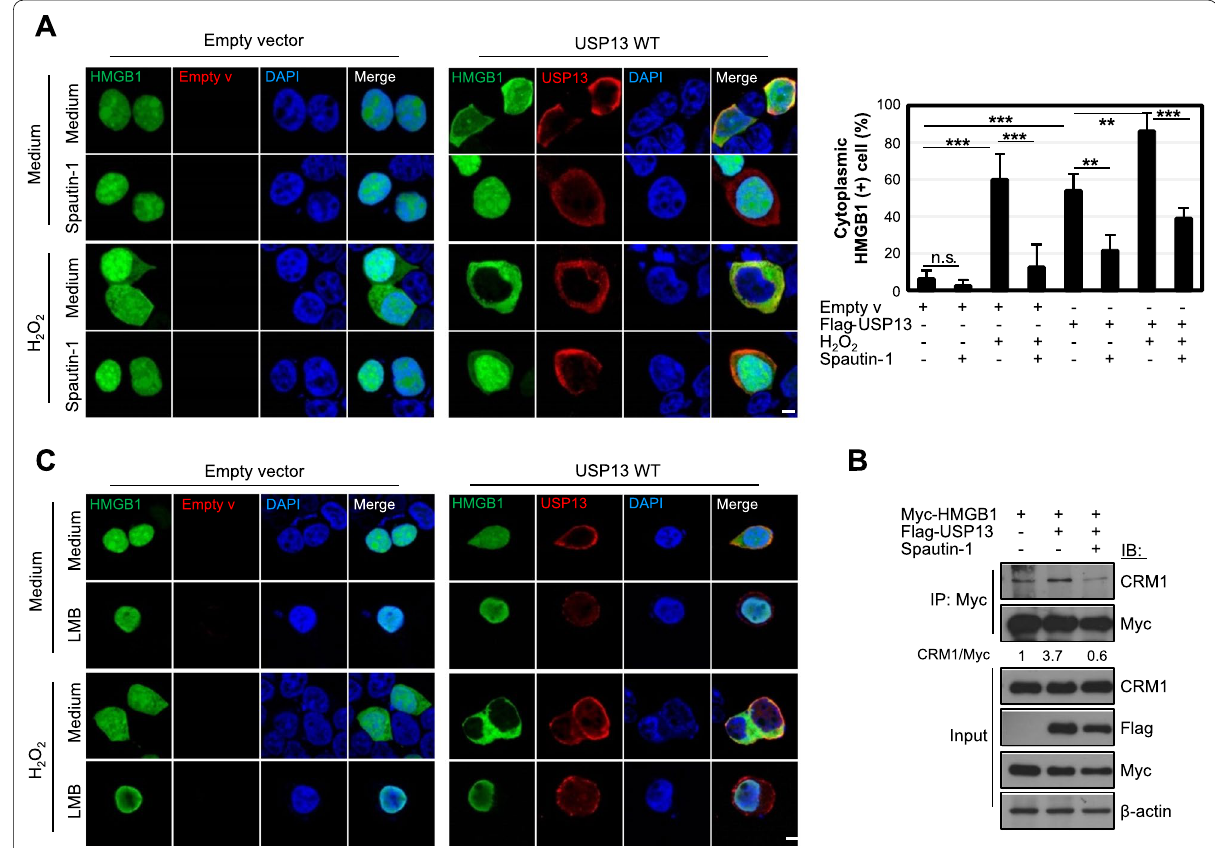
Fig. 5 USP13 regulates subcellular localization of HMGB1. A , C HEK293T cells were co‑transfected with both GFP‑HMGB1 and Flag‑USP13 or empty plasmids for 48 h. Cells were treated with 10 μM Spautin‑1 for 2 h or 20 ng/mL leptomycin B (LMB) for 20 h and further treated with 50 μM H 2 O 2 for 4 h. HMGB1 was observed after immunofluorescent staining. Over 100 cells were counted for cytoplasmic GFP‑HMGB1 ( n.s. no significant, N 3. ** p < 0.01 and *** p < 0.001 using Tukey’s honestly significant difference post‑hoc test for multiple comparisons. B HEK293T = cells were co‑transfected with Myc‑HMGB1 and Flag‑USP13 plasmids for 48 h and treated with 10 μM Spautin‑1 for the last 18 h and WCLs were immunoprecipitated (IP) with anti‑Myc antibody and immunoblotted (IB) with anti‑CRM1 antibody. Data represents one of two similar independent experiments in